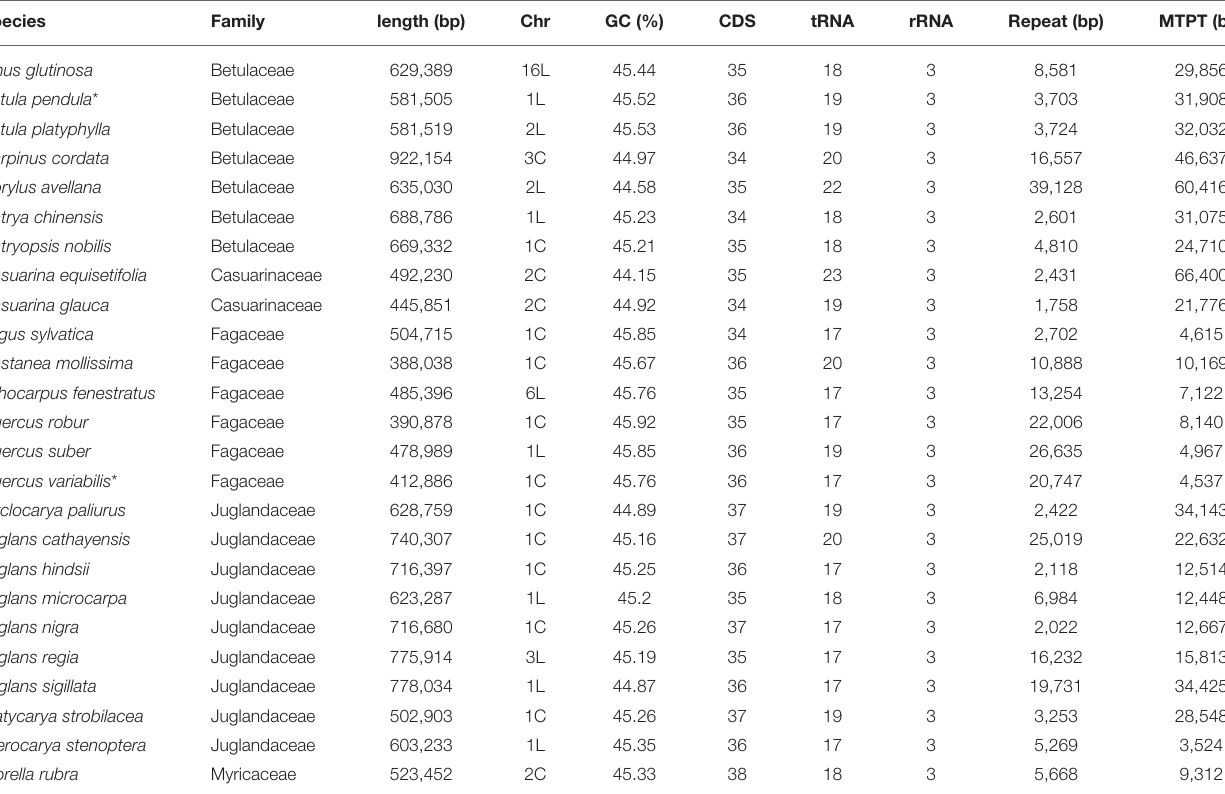
TABLE 1 | Basic information of Fagales mitogenomes. In the column “Chr,” the number means the total number of chromosomes, while “C” and “L” behind represent “circular” and “linear,” respectively.